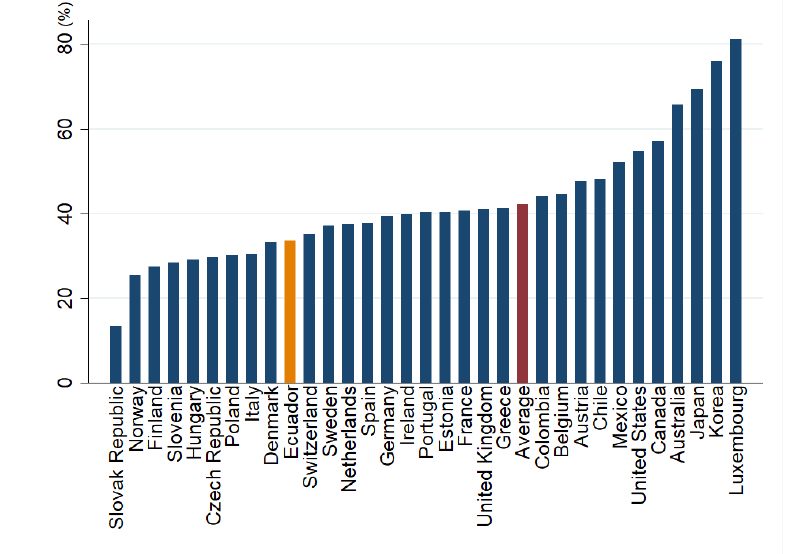
Figure 6: Share of metropolitan areas in overall population in the year